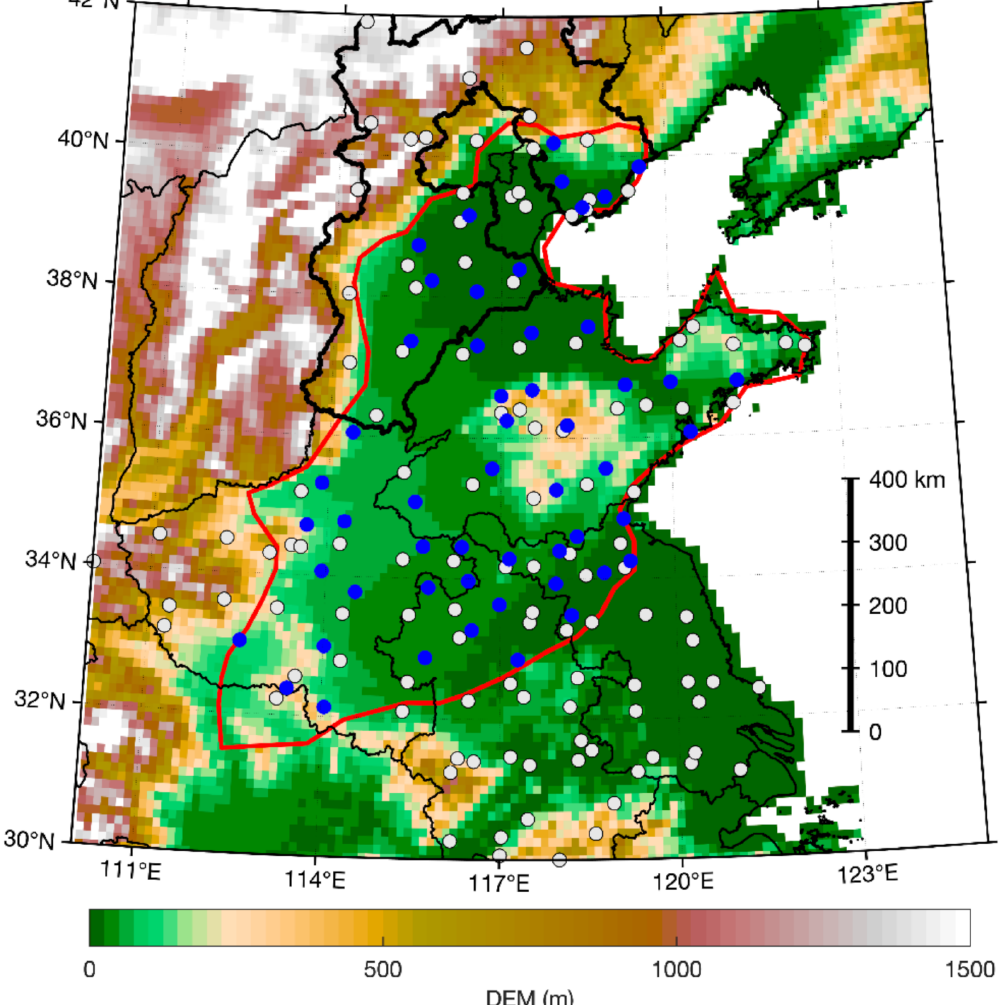
Figure 1. Map of elevation and rain stations in the North China Plain. The red line is the boundary line of the North China Plain. The thick black line is the boundary line of Hebei Province. The white points are daily rain gauges, and the blue points are hourly rain